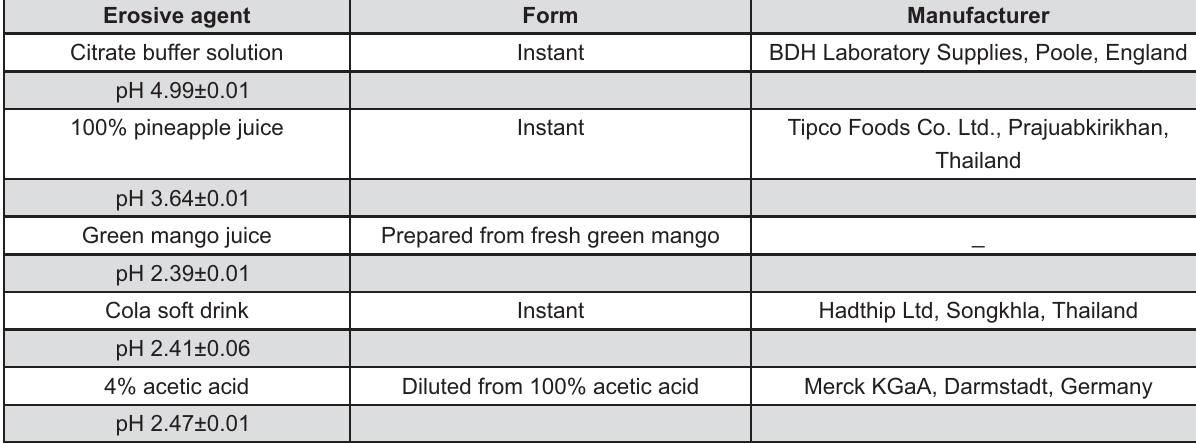
Table 1- Firing schedules for the porcelains used in the present